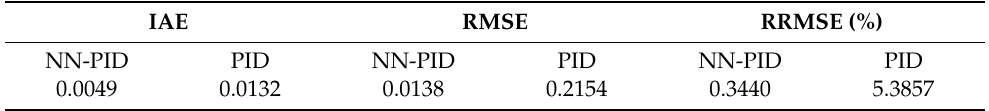
Table 2. Comparison of the different